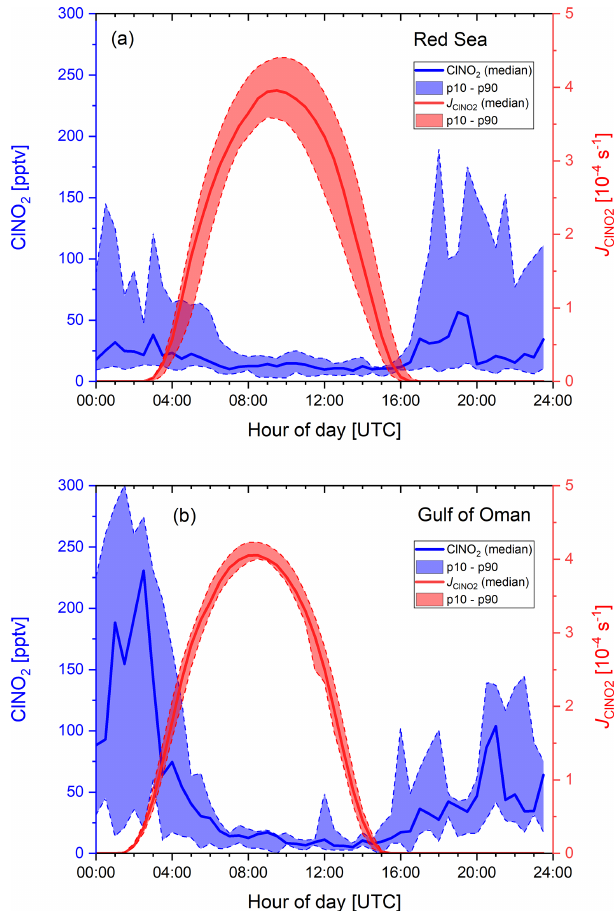
Figure 4. Diurnal profiles of ClNO 2 and its photolysis rate constant, J ClNO , for (a) the Red Sea and (b) the Gulf of Oman. The solid 2 lines represent the median values, the shaded areas correspond to the 10th and 90th